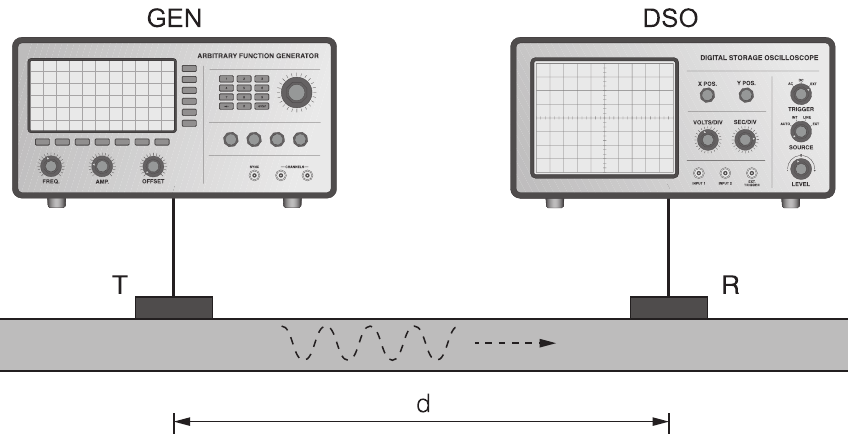
Figure 1. A schematic diagram of the measurement setup, consisting of a signal generator (GEN), a digital storage oscilloscope (DSO) and two transducers, one for transmitting (T) and one for receiving (R) the guided acoustic wave signals, attached to the surface of the test specimen at a fixed distance (d). A typical signal recorded by the oscilloscope is demonstrated in Figure 2. In order